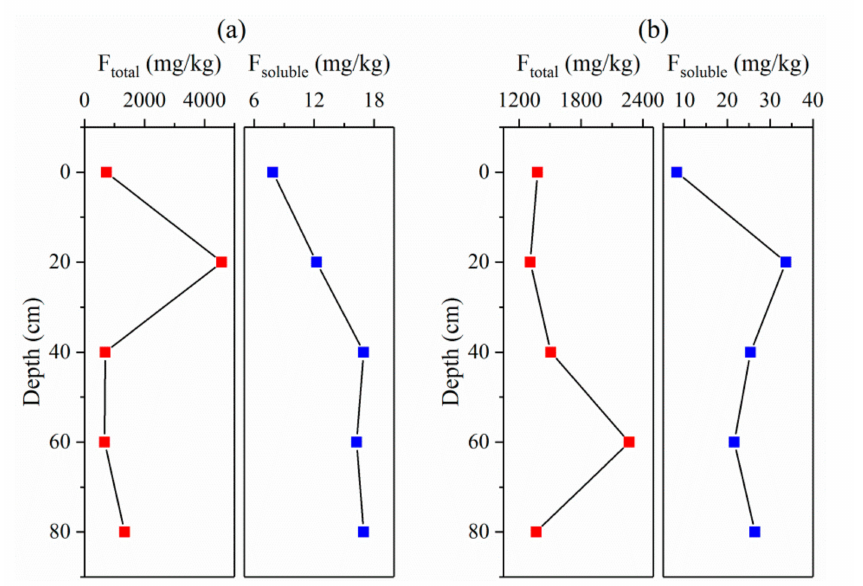
Figure 10. Distribution of fluoride in shallow soils in the Jiaolai Basin, Jiaodong Peninsula, eastern China. ( a ) Nanxiegou village, ( b ) Zhoujiazhuang